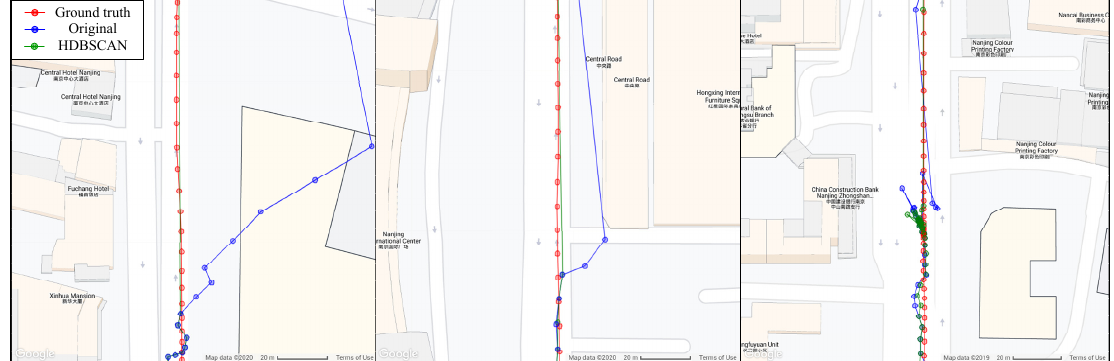
Figure 10. Epochs with insufficient normal observations are discarded to avoid wrong position solutions in harsh environments.